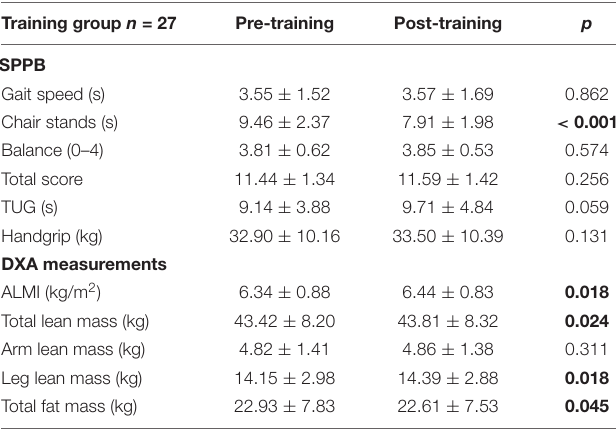
TABLE 2 | Changes in outcomes on lean body mass and physical function following 10 weeks of digital resistance training.